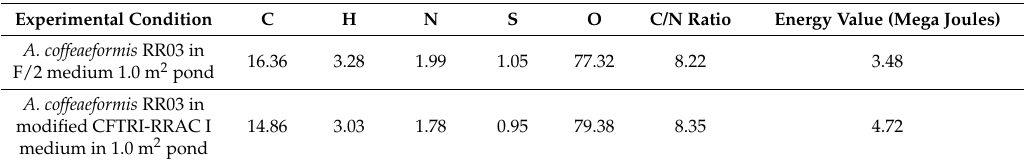
Table 3. Percentage of C, H, N, S, O, and C/N ratio of dry biomass of A. coffeaeformis RR03 under different conditions.